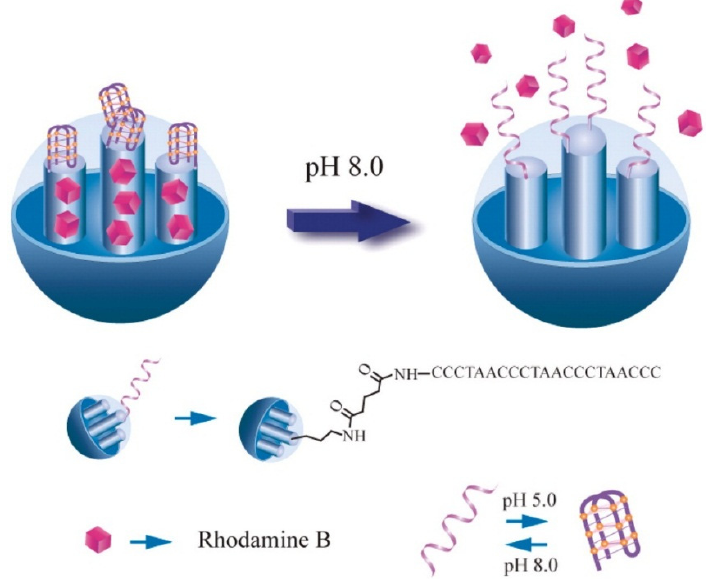
Figure 7. Schematic representation of proton-fueled release of a drug from the pores of MSNs capped with i -motif DNA. Reproduced with permission from [84]. Copyright Oxford University Press,